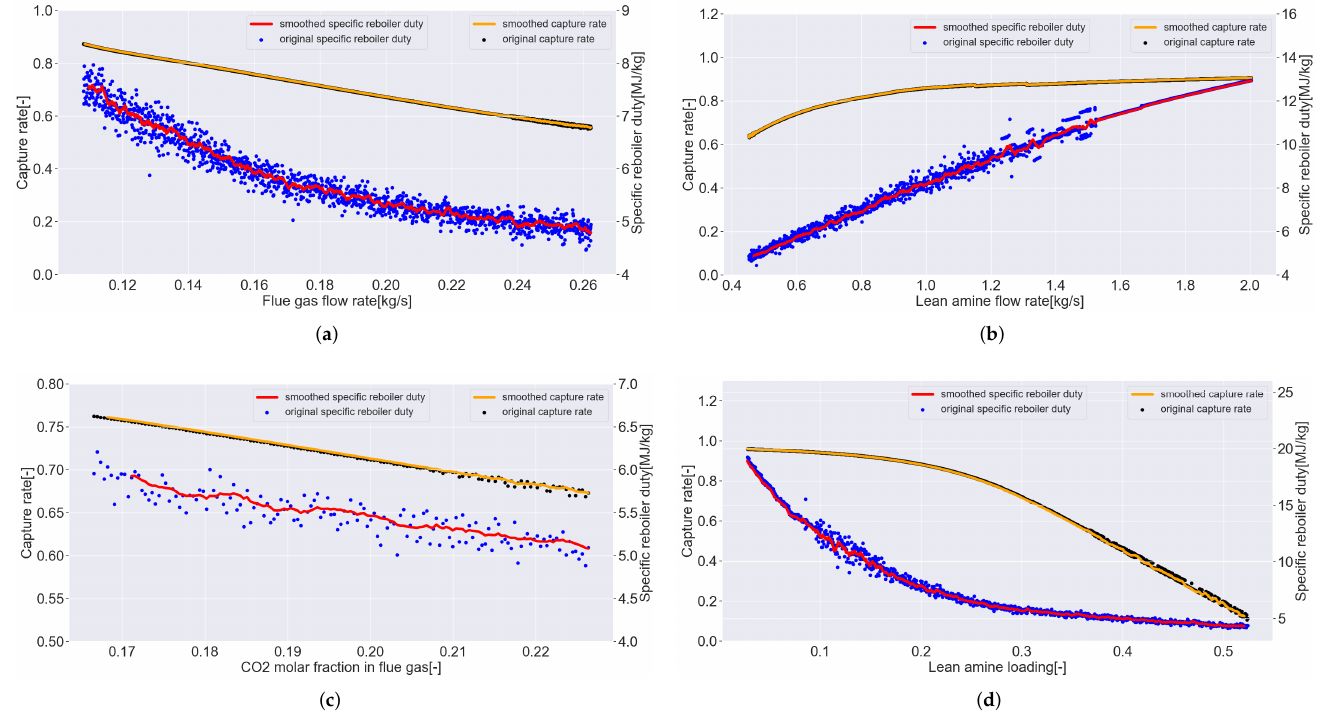
Figure 5. Plots of original data collected and smoothed curve for each independent variable and dependent variable. ( a ) Flue gas flow rate vs. capture rate/specific reboiler duty. ( b ) Lean amine flow rate vs. capture rate/specific reboiler duty. ( c ) CO 2 molar fraction in flue gas vs. capture rate/specific reboiler duty. ( d ) Lean amine loading vs. capture rate/specific reboiler